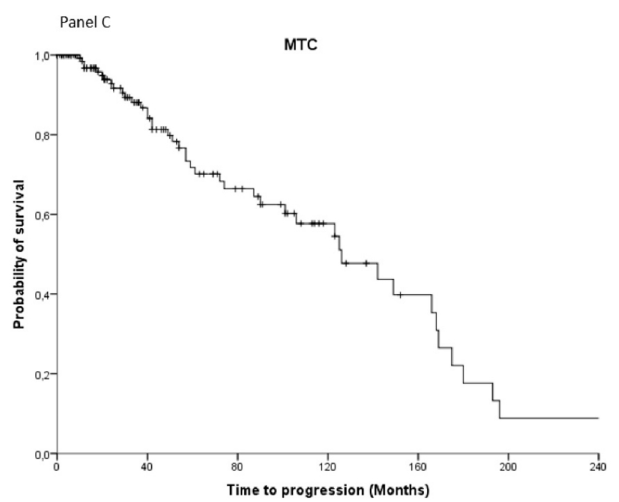
Figure 1. Overall progression-free survival ( A ) and specific progression-free survival for PCT ( B ) and MTC ( C )